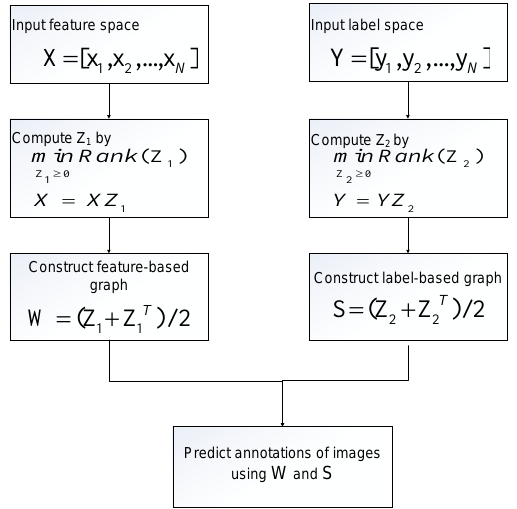
Figure 2. Flowchart of Multi-Label Classification based on Low Rank Representation